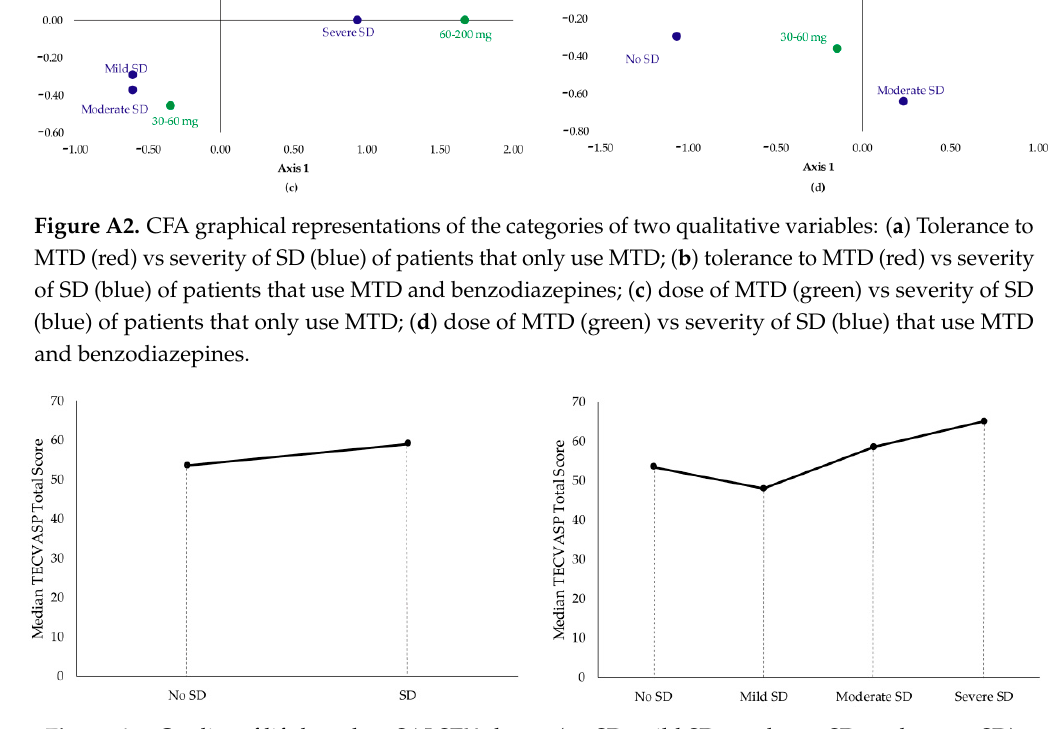
Figure A3. Quality of life based on SALSEX classes (no SD, mild SD, moderate SD, and severe SD).